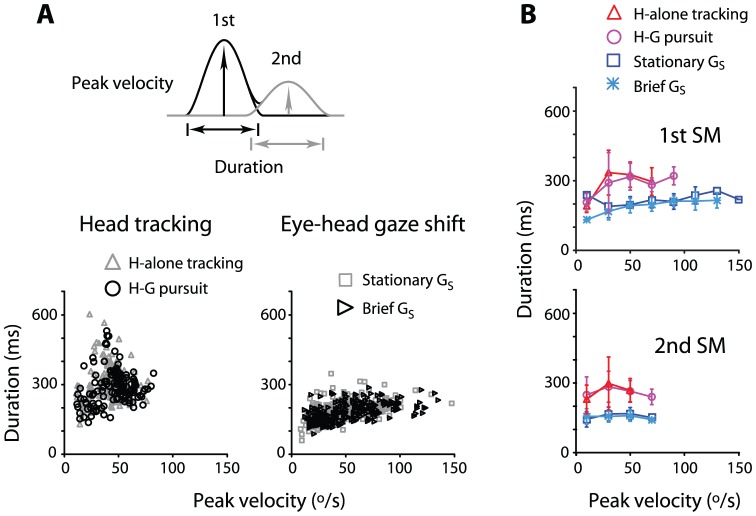
Head tracking movements and eye-head combined gaze shifts distinguished by submovement duration as a function of peak velocity.
A: Data separated for head tracking and eye-head combined gaze shifts. B: Same data as in A, separated for first and second submovements. Data is plotted as mean ± S.D. Note during head tracking, the submovements exhibited relatively longer duration independent of peak velocity. This tendency persisted for the first and second submovements.